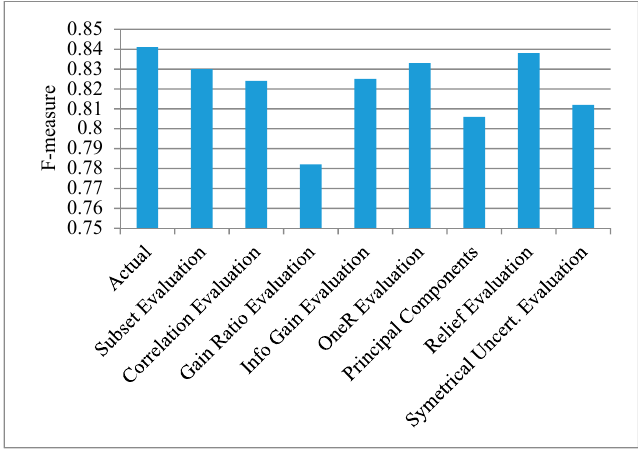
Figure 3. Random Forest performance based on the F-measure for the Actual 1024 attributes and the F-measure based on the attributes selected by the corresponding algorithm.